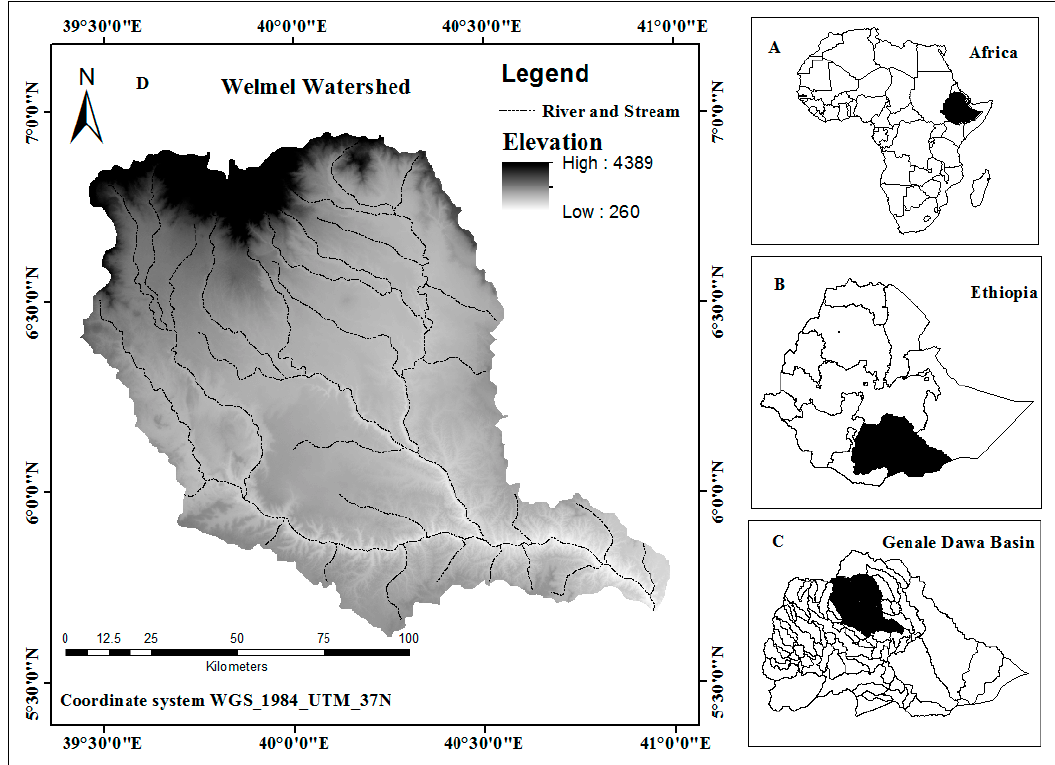
Figure 1. ( A ) Relative location of Ethiopia to Africa, ( B ) Genale Dawa Basin relative location with Ethiopia, ( C ) Welmel Watershed in darker color, relative location with Genale Dawa Basin, and ( D ) Welmel watershed location map.